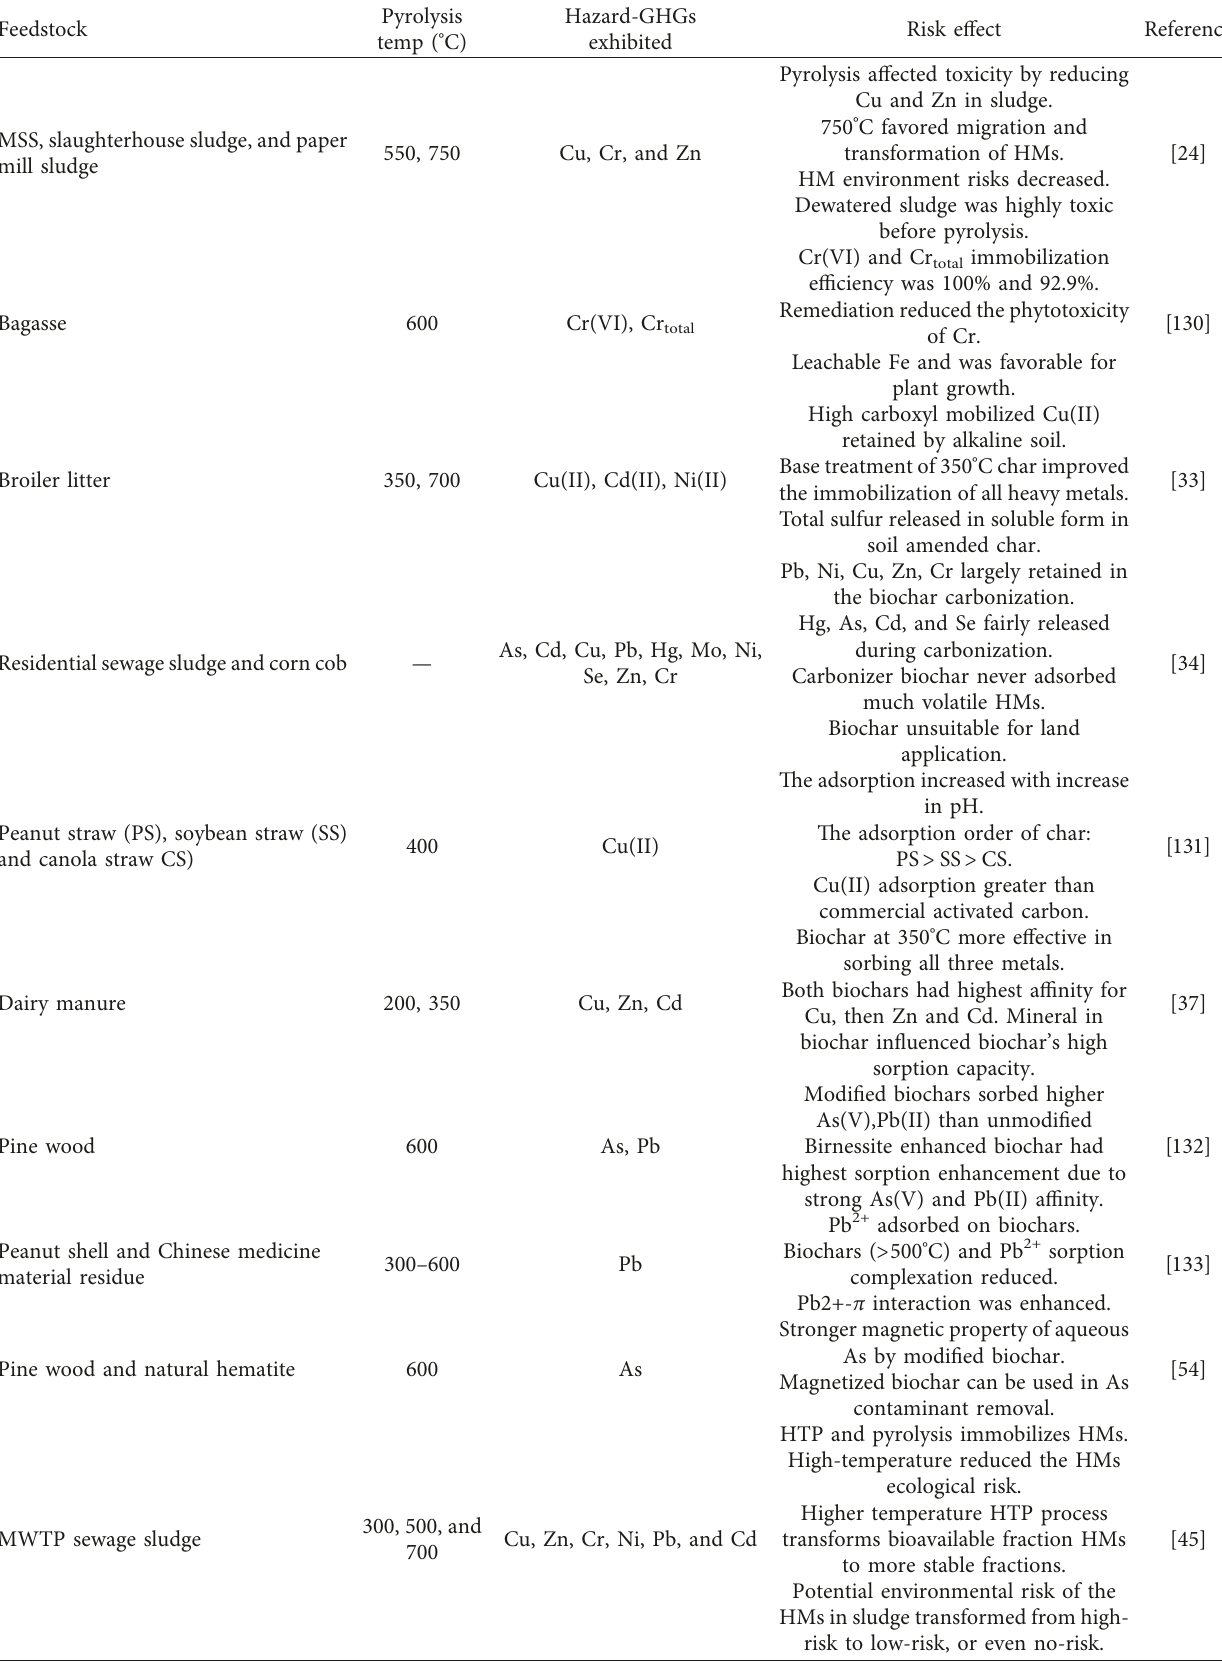
Table 4: Heavy metals identified and risk effect in biochar